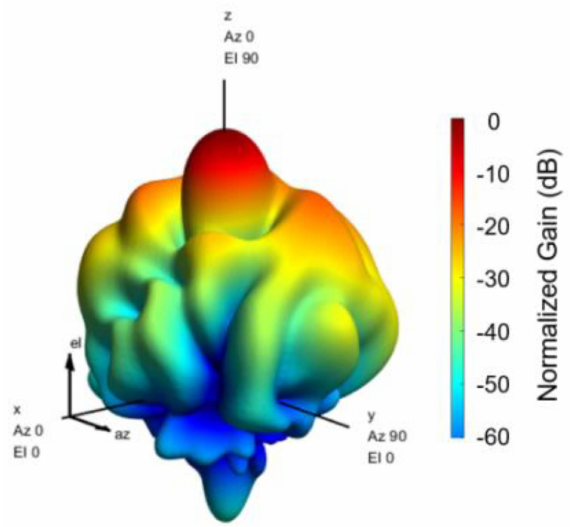
Figure 9. The 3D radiation pattern of the sparse array synthesized by MCDE